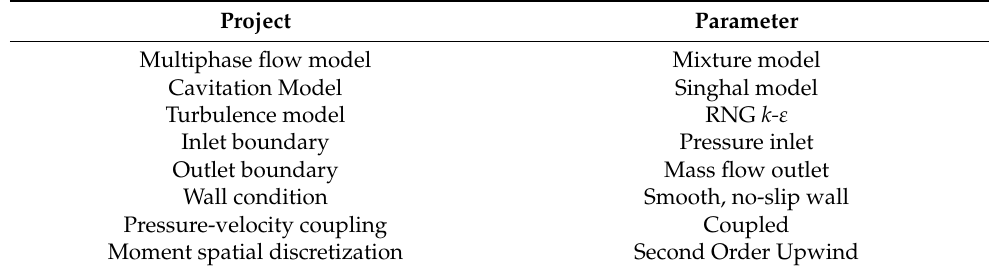
Table 4. Numerical simulation